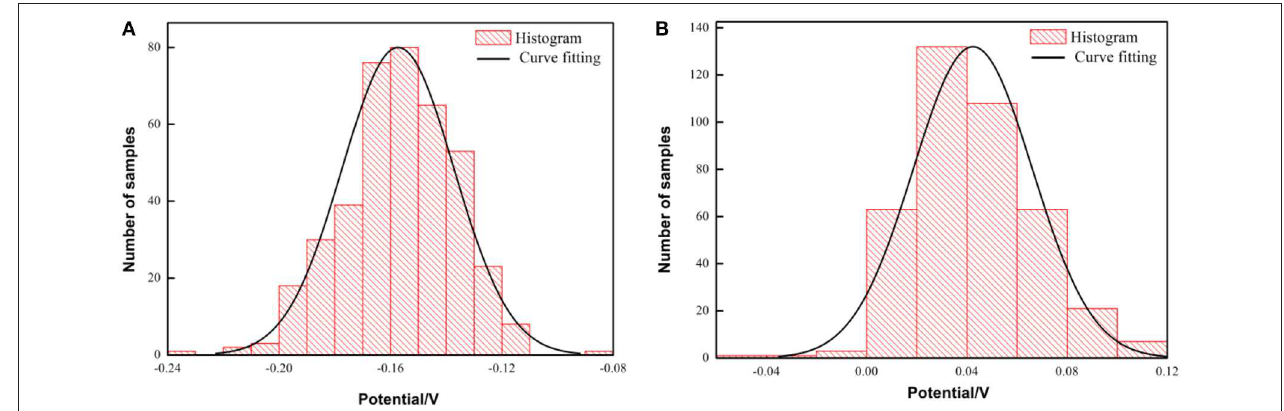
FIGURE 12 | Histogram and fitting curve of Kelvin potential distribution on the surface of PH13-8Mo stainless steel after exposure for 5 years (A) bare samples; (B) pre-passivated